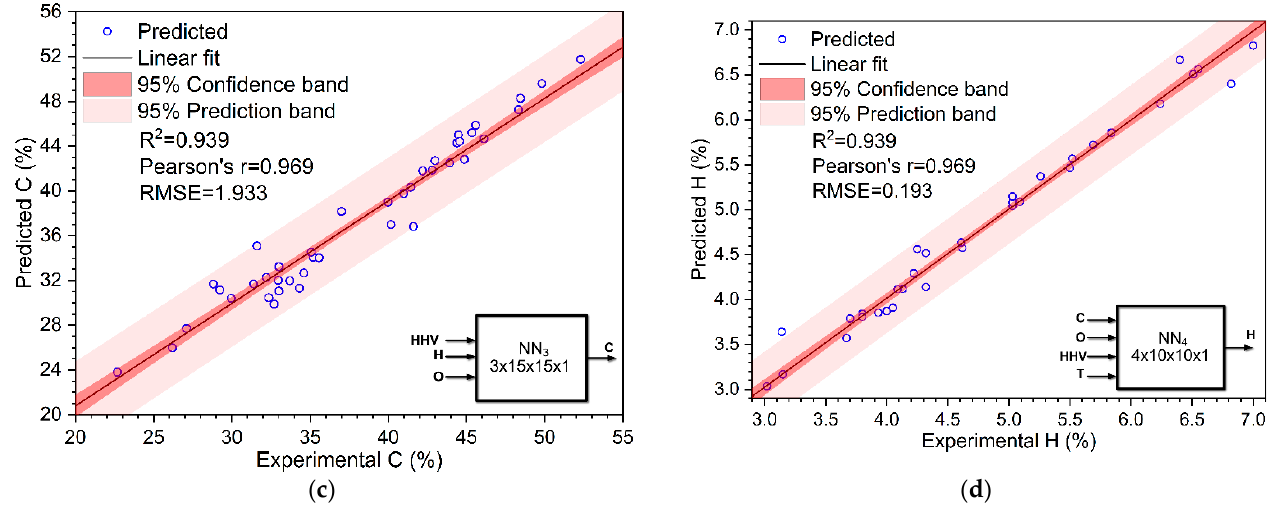
Figure 6. Predicted and experimental data regression analysis for: ( a ) HHV using NN 1 ; ( b ) HHV using NN 2 ; ( c ) carbon using NN 3 ; ( d ) hydrogen using NN 4